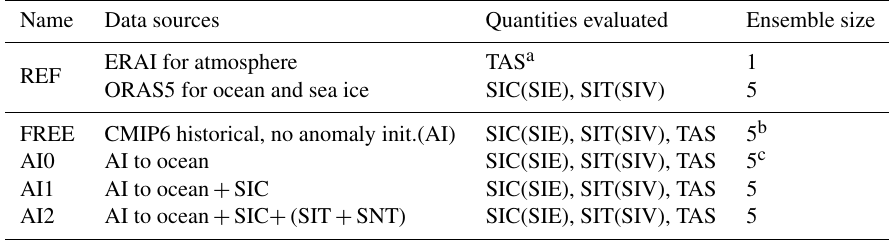
Table 1. List of experiments, reference data sets and variables in forecast skill assessment.